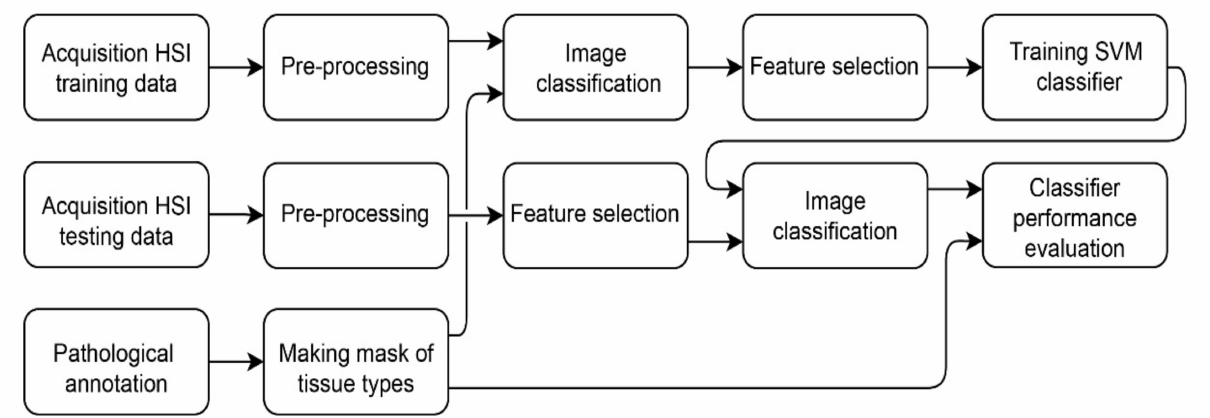
Figure 3. Method for training and classifying the tumor and non-tumor